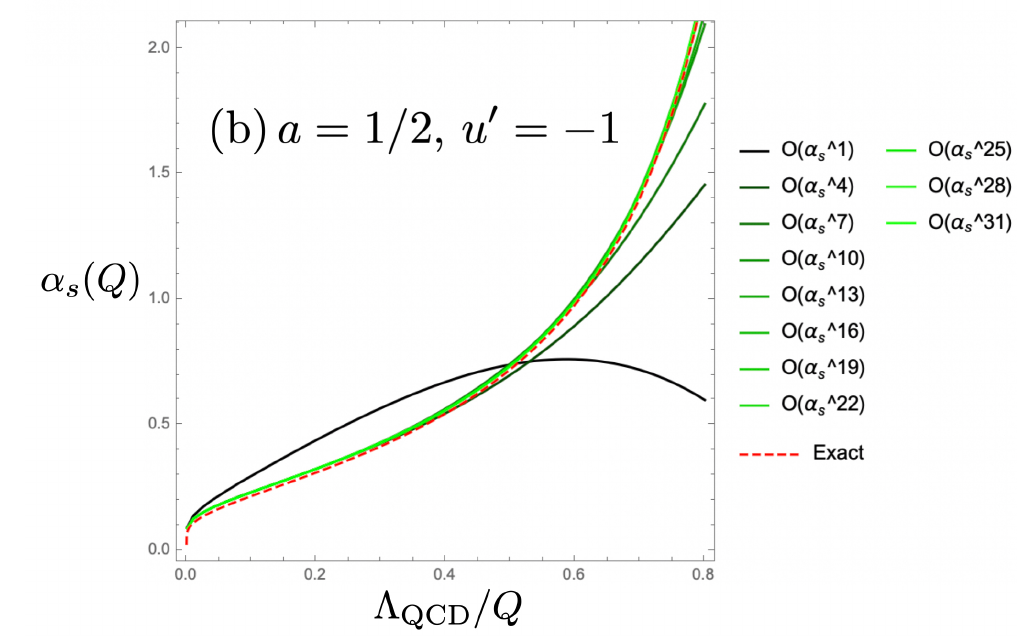
JHEP06(2022)157